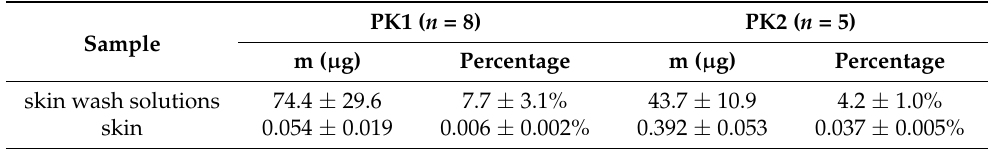
Table 2. STL amount and percentage of the applied dosage (961 µ g (PK1) or 1048 µ g (PK2)) in skin wash solutions and skin